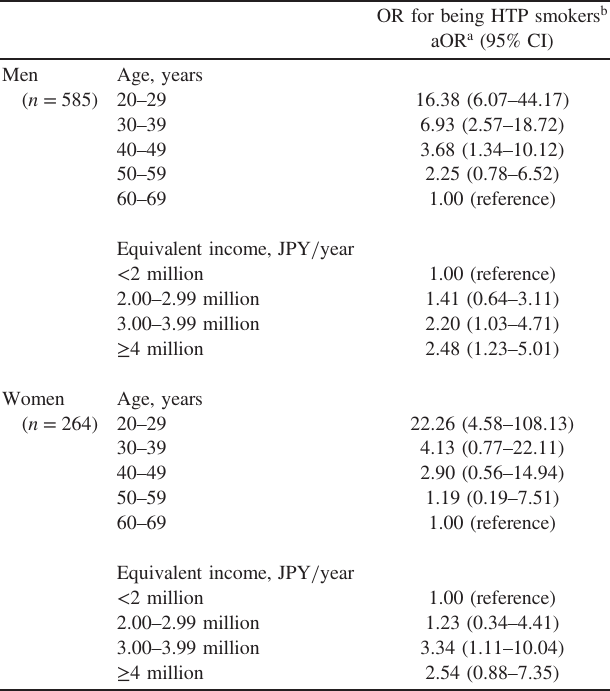
Table 2. Odds ratios of age and equivalent income for smokers (only combustible cigarette or HTP) versus non-smoker using multinomial logistic regression analysis